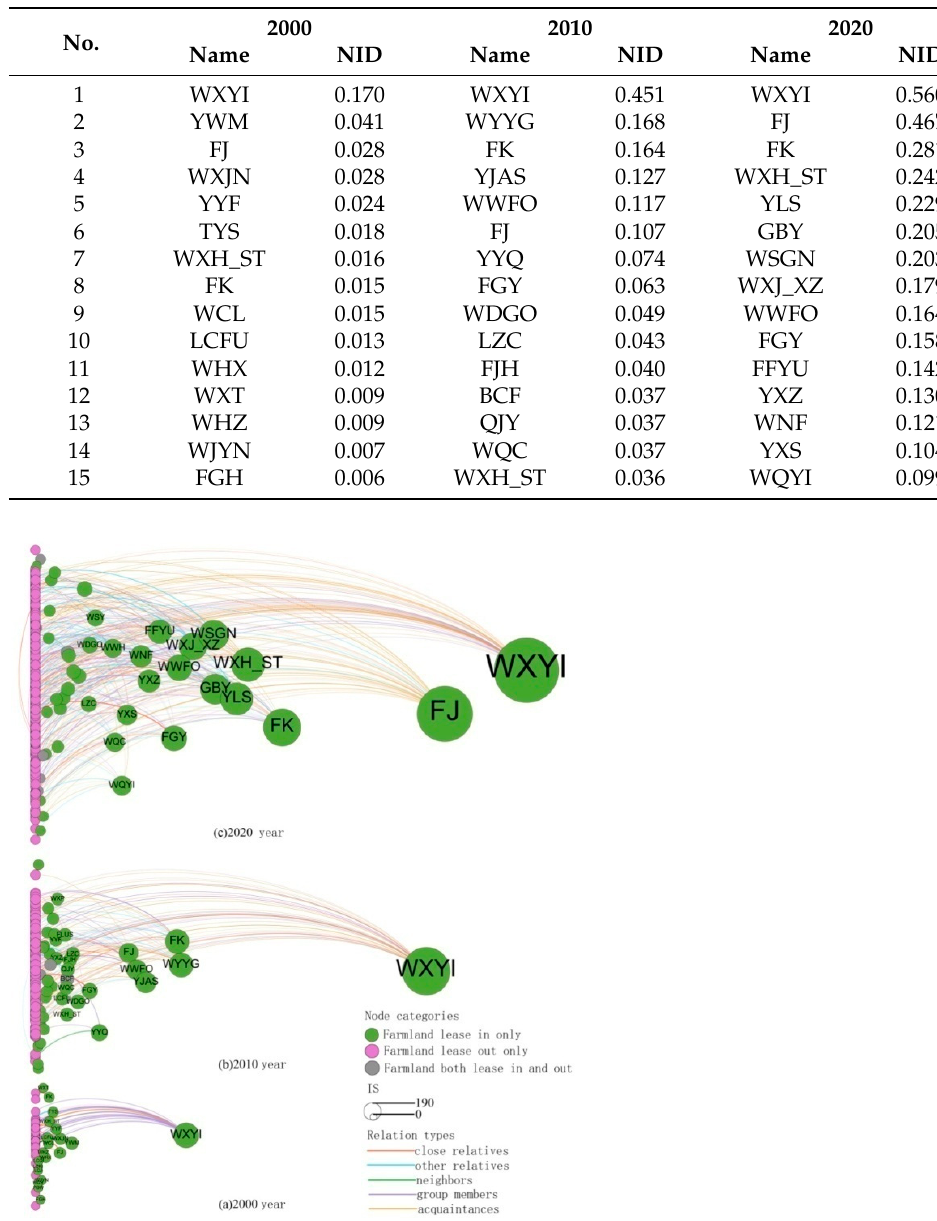
Table 4. NIDs of top15 nodes at different time points.